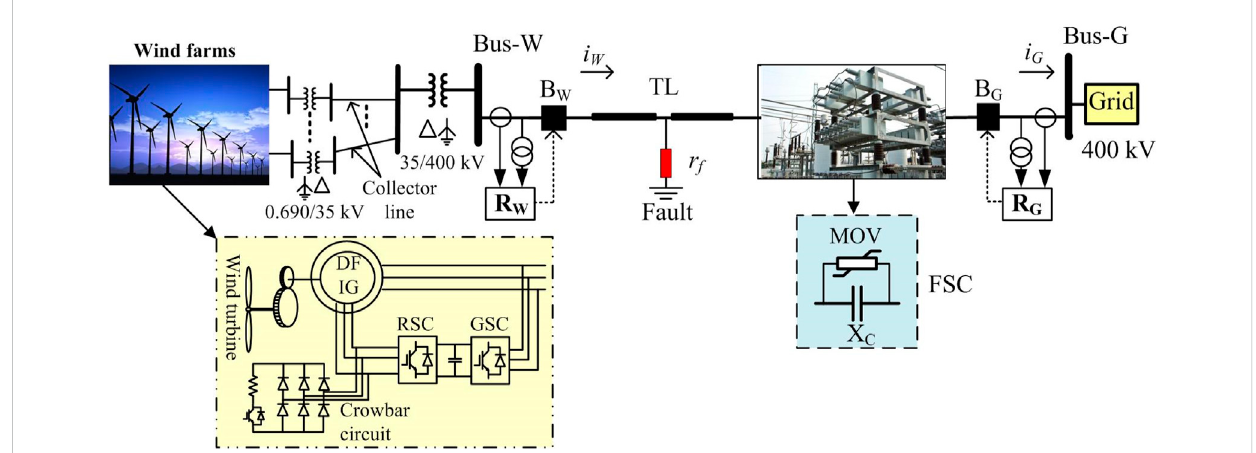
FIGURE 1 Single-line diagram of a two-bus test power system (in this study, the zone-1 reach of R W and R G is set equal to 80% length of the TL).